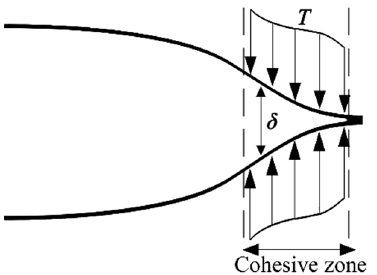
Figure 1. Schematic diagram of cohesive model.